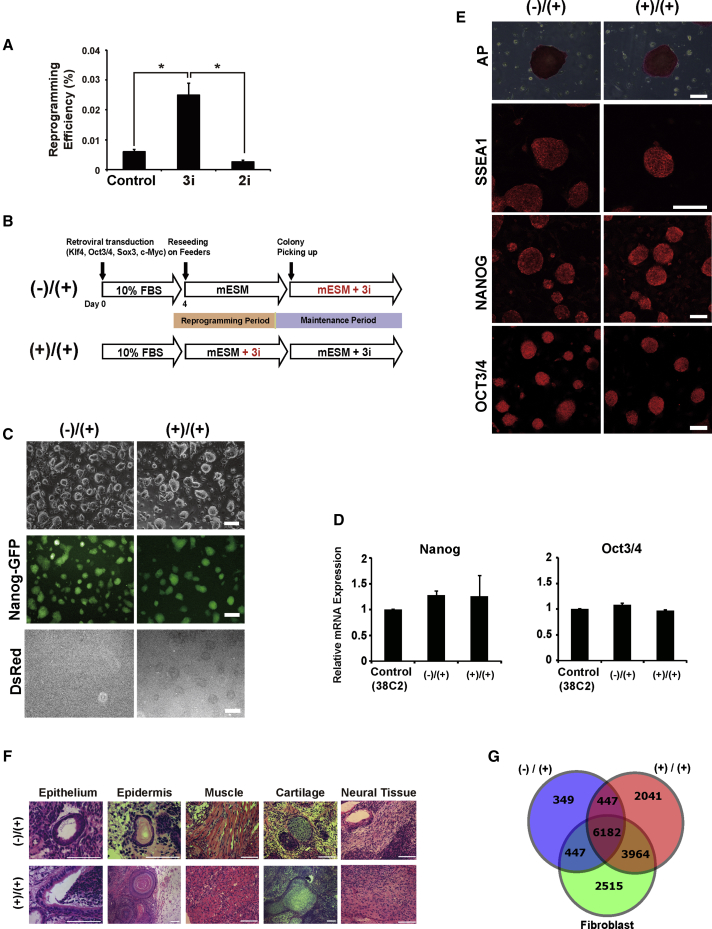
Generation of Two Groups of Murine iPSCs Using Small Molecules(A) The reprogramming efficiency of 3i- or 2i-treated fibroblasts compared with untreated cells is shown. iPSC colonies were identified based on ESC-like morphology and expression of Nanog-GFP detected under a fluorescence microscope (n = 3; ∗p < 0.05).(B) The schematic representations of two reprogramming protocols used in this study. In our protocol, Nanog-GFP transfected fibroblasts were cultured in 10% FBS medium, re-seeded on feeders, and switched to murine ESC medium. While the 3i chemicals were used only after colonies were picked (maintenance period) in the (−)/(+) condition, the 3i chemicals were used during both the reprogramming phase (including the period from day 2 to day 12) and the maintenance phase in the (+)/(+) condition. The 3i chemicals were used at the following concentrations: 3 μM CHIR99021, 0.8 μM PD184352, and 0.8 μM SU5402.(C) Representative images of iPSC colonies generated using the (−)/(+) or (+)/(+) protocol. Both colony types exhibited a typical ESC morphology and expressed Nanog-GFP homogeneously. The silencing efficiency of dsRed, which was transduced together with OSKM as a transgene control while generating the iPSCs, was verified. Scale bar, 100 μm.(D) qPCR for expression of pluripotency markers (Nanog and Oct3/4) in iPSCs. The averages and SD of three different clones of the (−)/(+) or (+)/(+) iPSC lines are represented. 38C2 is a control iPSC clone that was derived from the same Nanog-GFP mouse line (n = 3; ∗p < 0.05).(E) Representative images of AP staining and immunofluorescence staining of pluripotent markers (SSEA1, Nanog, and OCT3/4) in both the (−)/(+) and (+)/(+) iPSC lines. Scale bars, 200 μm (AP staining) and 100 μm (immunofluorescence staining).(F) H&E staining of teratomas derived from (−)/(+) or (+)/(+) iPSCs. Cells were transplanted into the testes of severe combined immunodeficiency mice. After 3 weeks, tumors were sectioned. Gut-like epithelial tissues (left), epidermal tissues, striated muscles, cartilage, and neural tissues (right) are shown. Scale bars, 200 μm.(G) The results of comprehensive DNA methylation analysis with MBD-seq. Venn diagram of unique and shared genes with methylated regions among (−)/(+) iPSCs (blue), (+)/(+) iPSCs (red), and fibroblasts (green) (n = 3, FDR < 0.05). Error bars represent mean ± SEM from three independent experiments (n = 3).